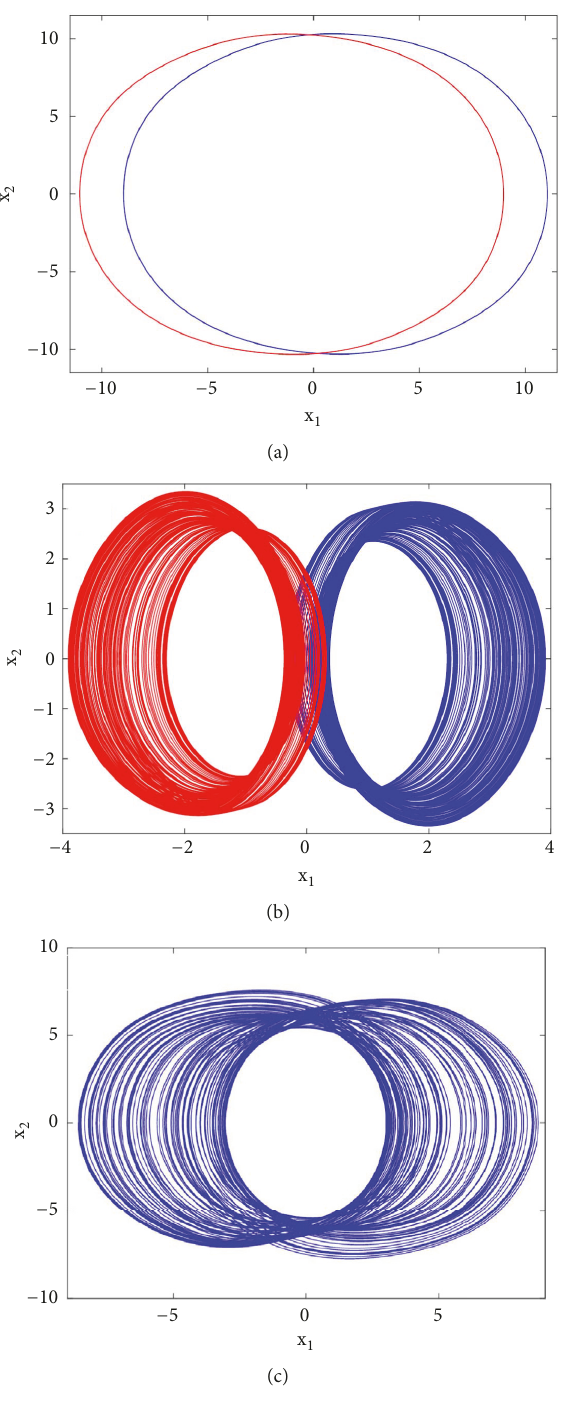
Figure 10: Two-dimensional projections (x 1 -x 2 ) of five coexisting attractors for a 2 = 2.71 (a pair of chaotic attractors, a pair of period-1 limit cycle, and a symmetric chaotic attractor) with the rest of system’s parameters as follows: b = a 1 = 3, a 0 = 1.75, a 3 = 1, a 4 = 0.0054. Initial states are given in Table